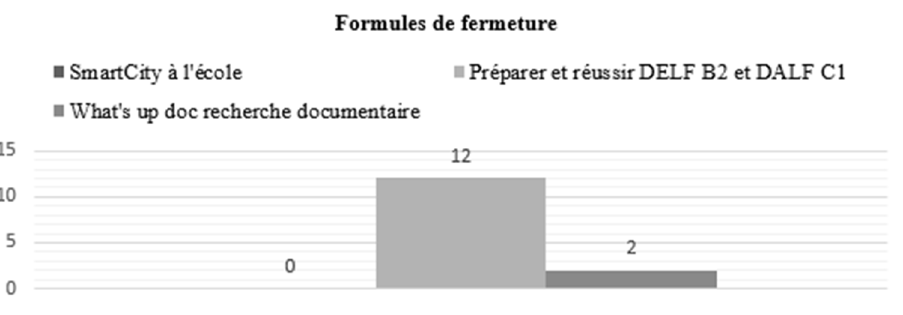
Fig. 5. Les formules de fermeture de conversation sur les forums étudiés des trois